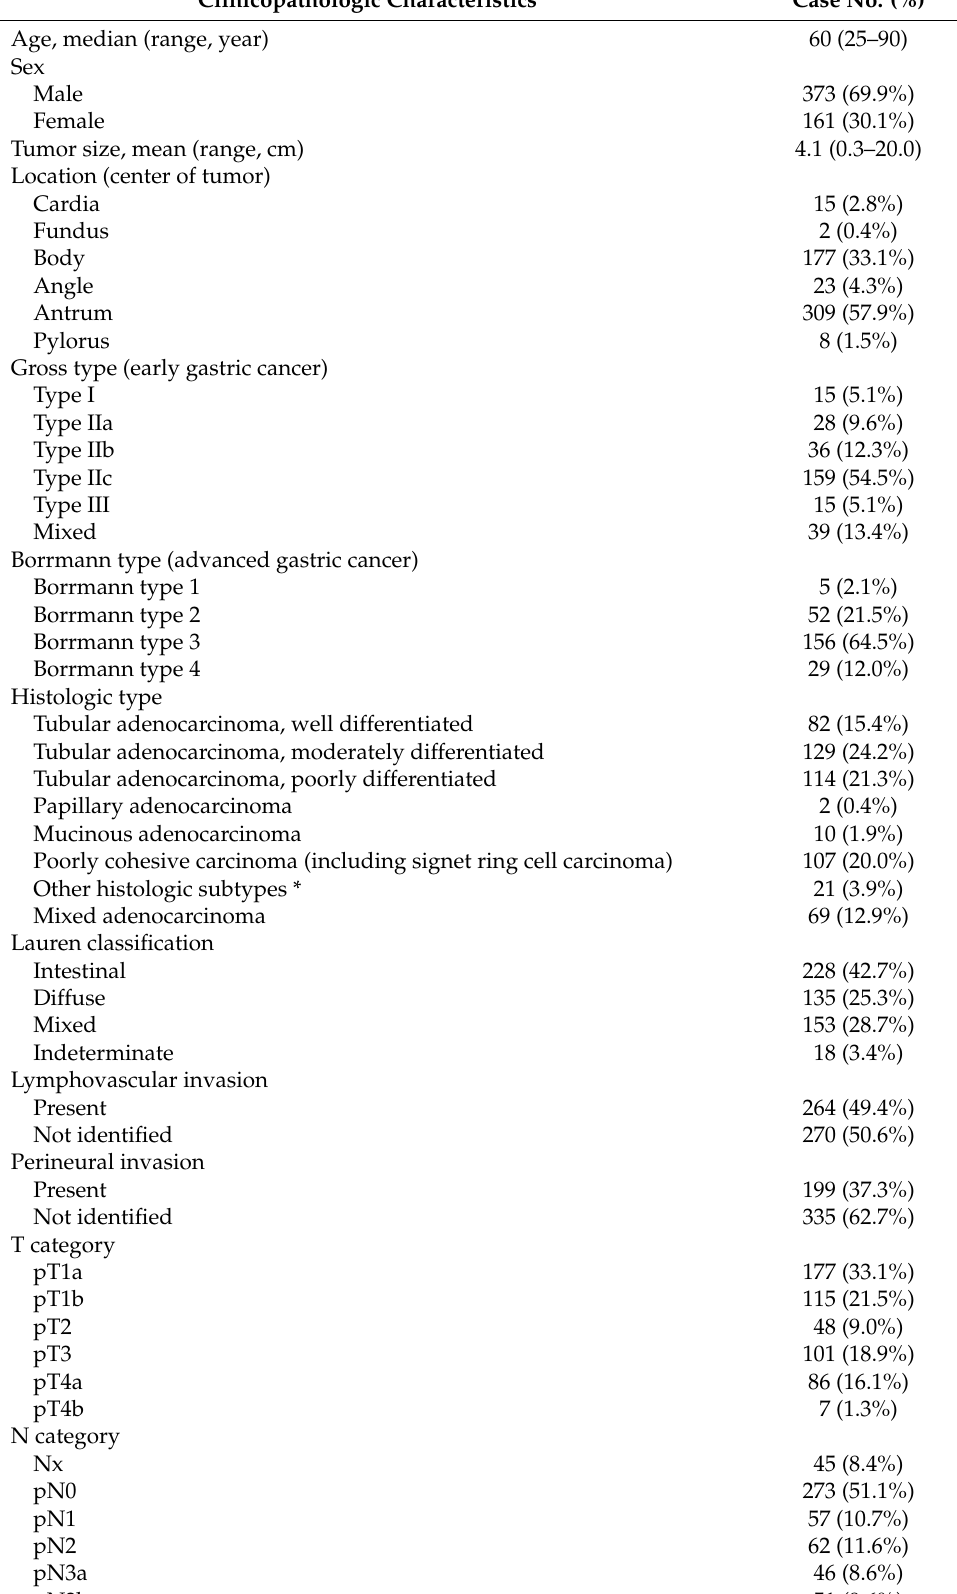
Table 1. Baseline characteristics of selected cases ( n =